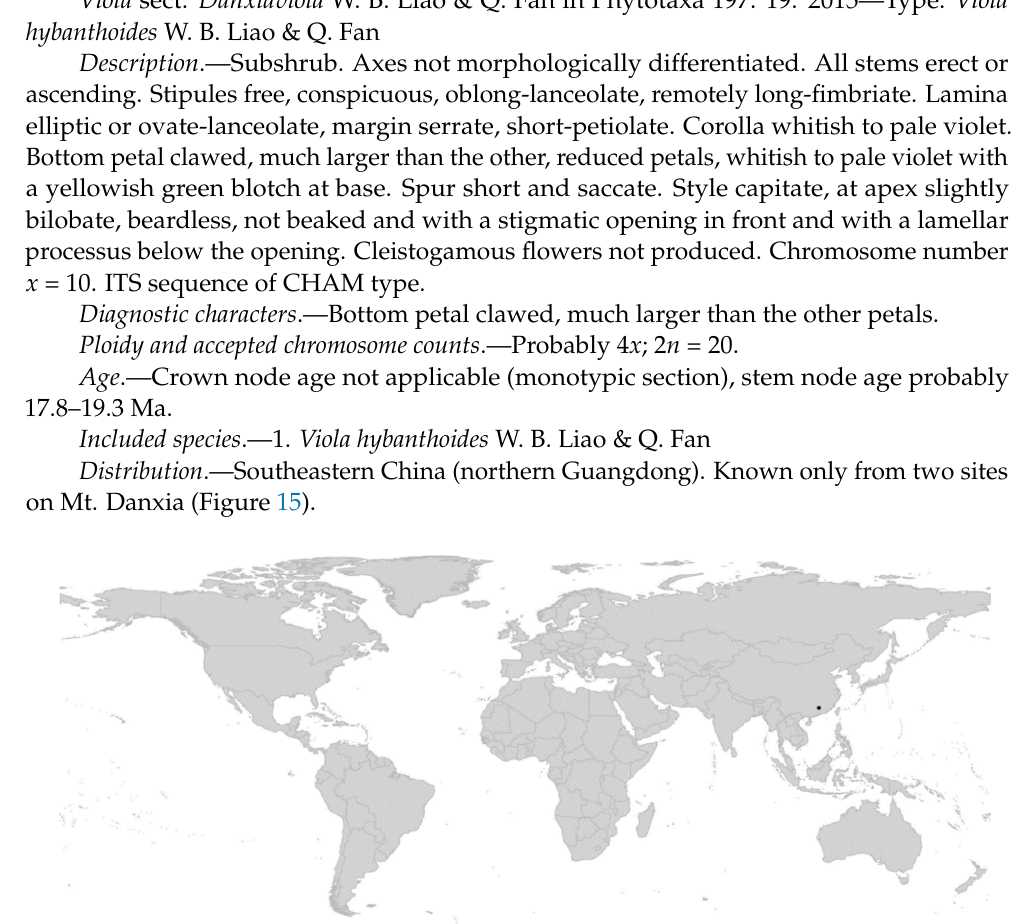
Becker [1] nor in the phylogeny of Marcussen et al. [28].